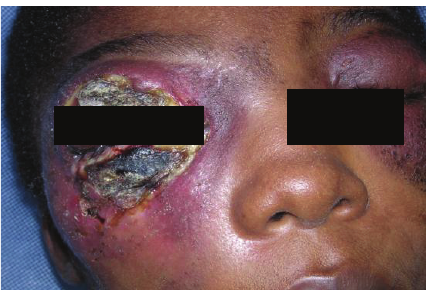
Figure 3: Facial BU above and beneath right palpebral